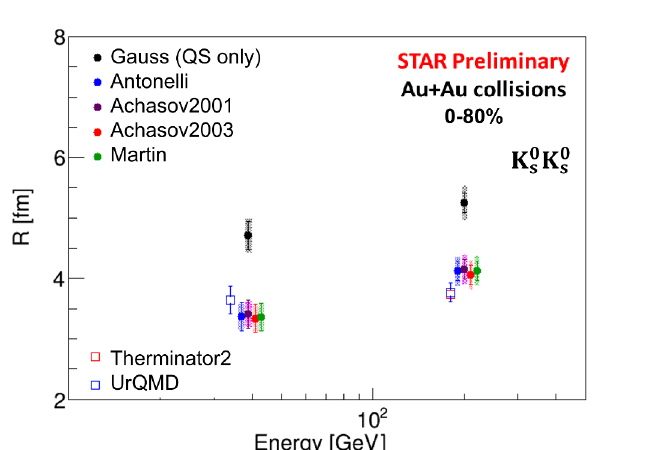
Figure 4. Energy dependence of the source sizes observed for the K 0 lisions. The filled markers are results from the experiment, and the empty markers correspond with model